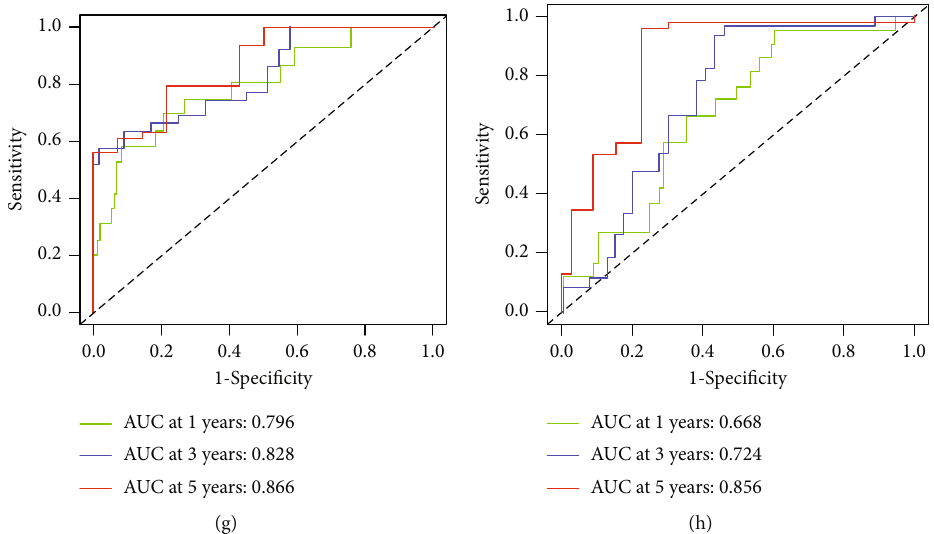
Figure 7: Independent analysis and construction of nomogram and performance assessment. (a, b) The univariate Cox regression analysis of prognostic factors. (c, d) The multivariate Cox regression analysis of prognostic factors. (e, f) Nomogram based on clinical factors and risk score. (g, h) Nomogram of AUC values for 1-, 3-, and 5-year survival